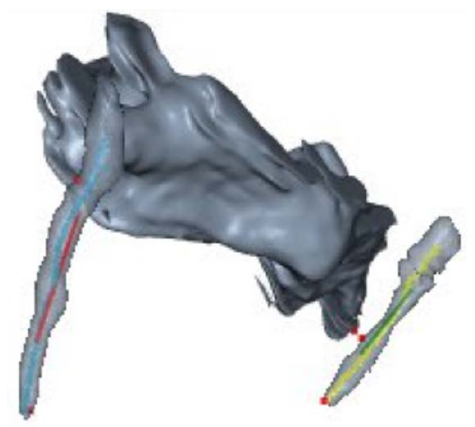
Figure 4. 3 D bony reconstruction. Figure 4. 3D bony